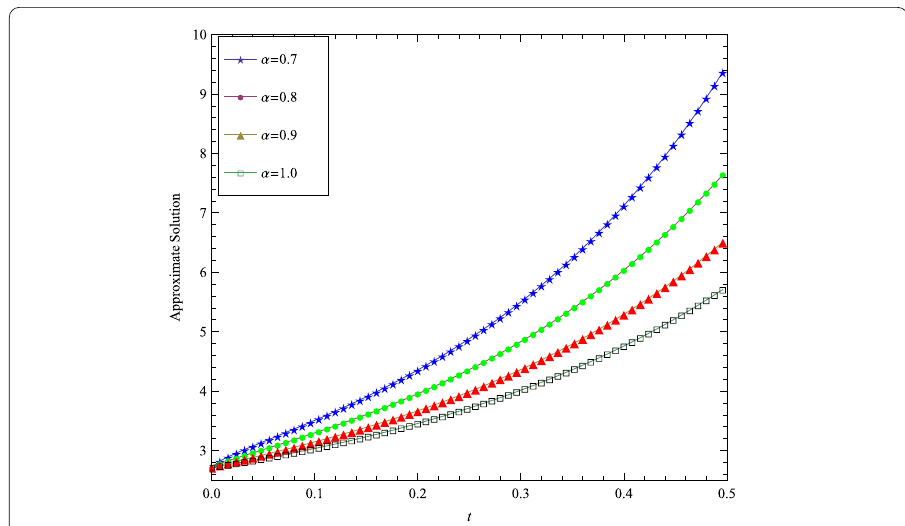
Figure 11 Plot of u ( x , t ) verses x time for different values of λ at t = 1 and (cid:2) = –1